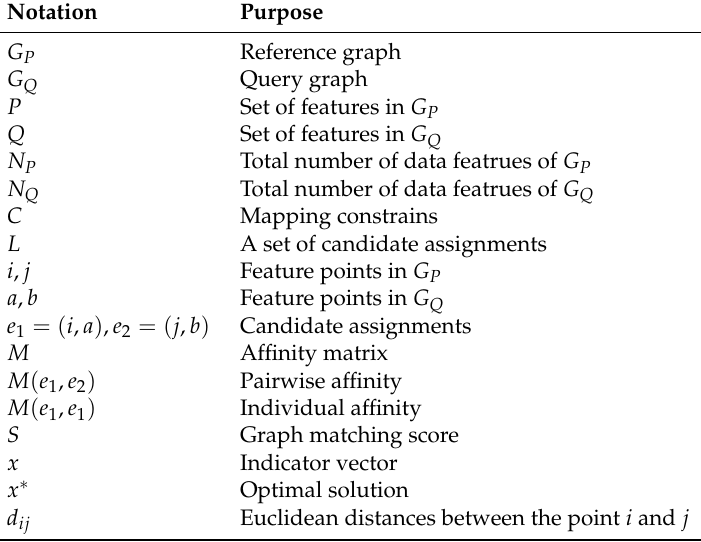
Table 1. Summarization of